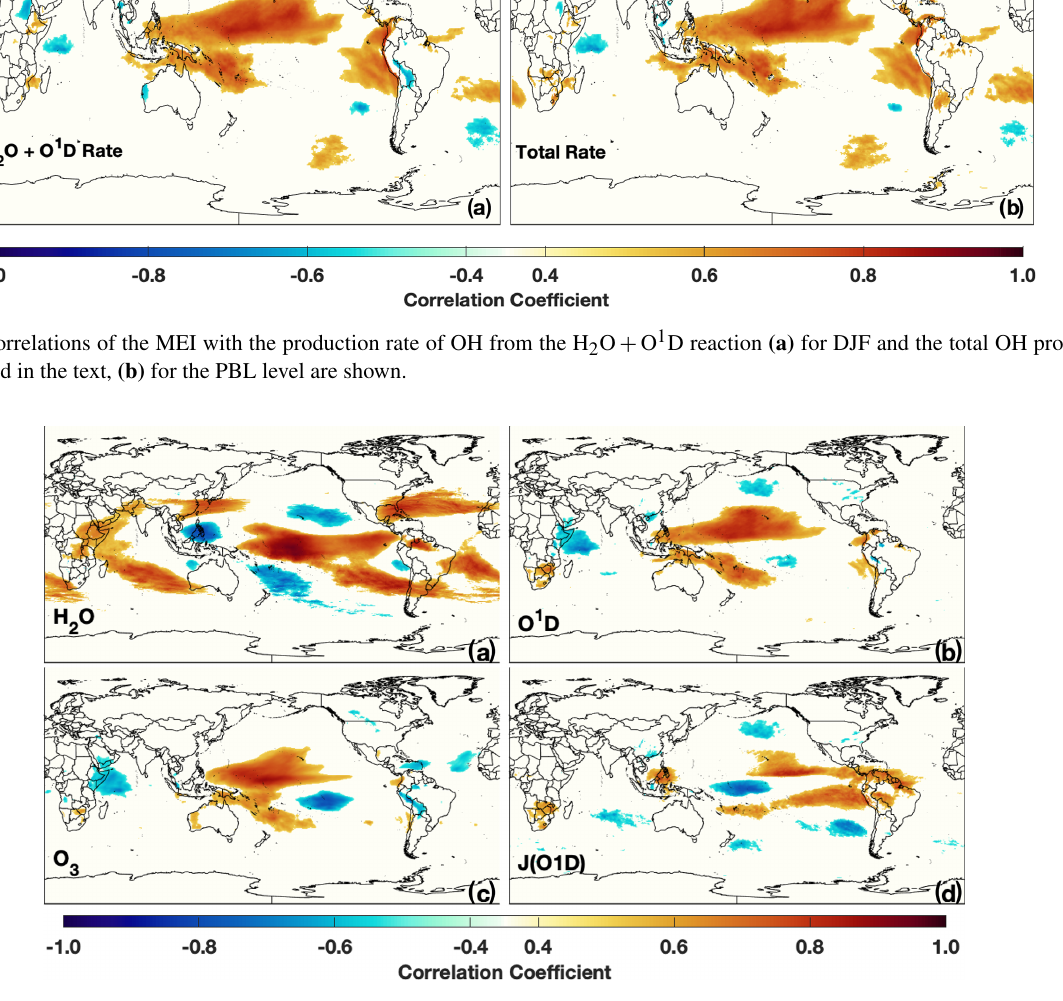
Figure 13. Correlation of the indicated species with the MEI for the PBL level for